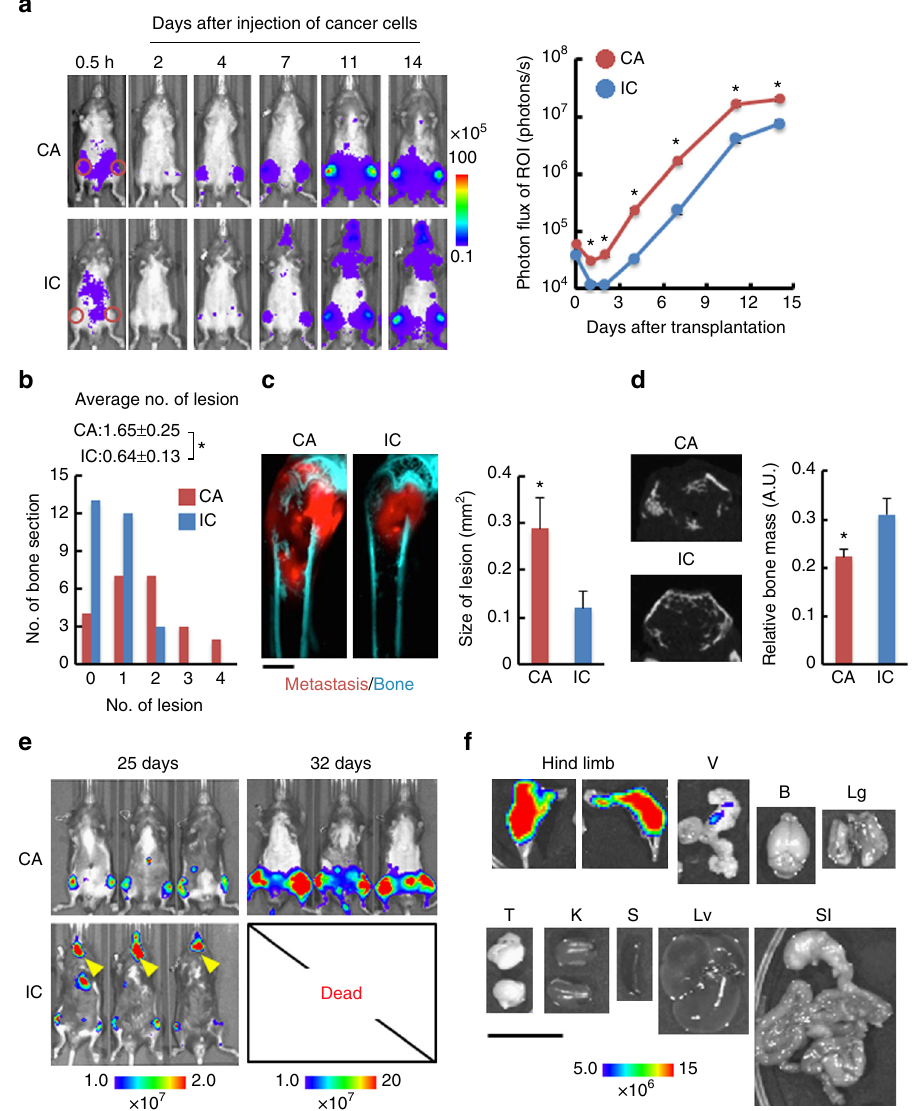
Fig. 2 CA injection accelerated development of bone metastasis in a hind limb. a Representative BL images (left) and BL intensity in region of interest (ROI) (right) at indicated days after LLC/luc cells injection by CA ( n = 16) or IC injection ( n = 12). Red circles in the images of 0.5 h indicate ROI. * P < 0.05 (two- side student ’ s t -test). Error bars indicate s.e.m. b Metastatic lesions in hind limb at 7 days after CA or IC injection of LLC/luc cells. The average number of a metastatic lesion per bone section was shown above the bar graph. n = 23 (CA), n = 28 (IC), * P < 0.05 (two-side student ’ s t -test). c Representative fl uorescence images (left) and quantitative analysis of bone metastasis in femur bones at 14 days after injecting LLC/mKO2-Rluc8.6 cells via CA or IC. Metastasis and bone were visualized with mKO2 fl uorescence (red) and tissue auto fl uorescence (cyan), respectively. A scale bar is 500 μ m. n = 8 (CA), n = 6 (IC). * P < 0.05 (two-side student ’ s t -test). d X-ray micro CT imaging (left) and quantitative analysis (right) of bone volume in the femur at 14